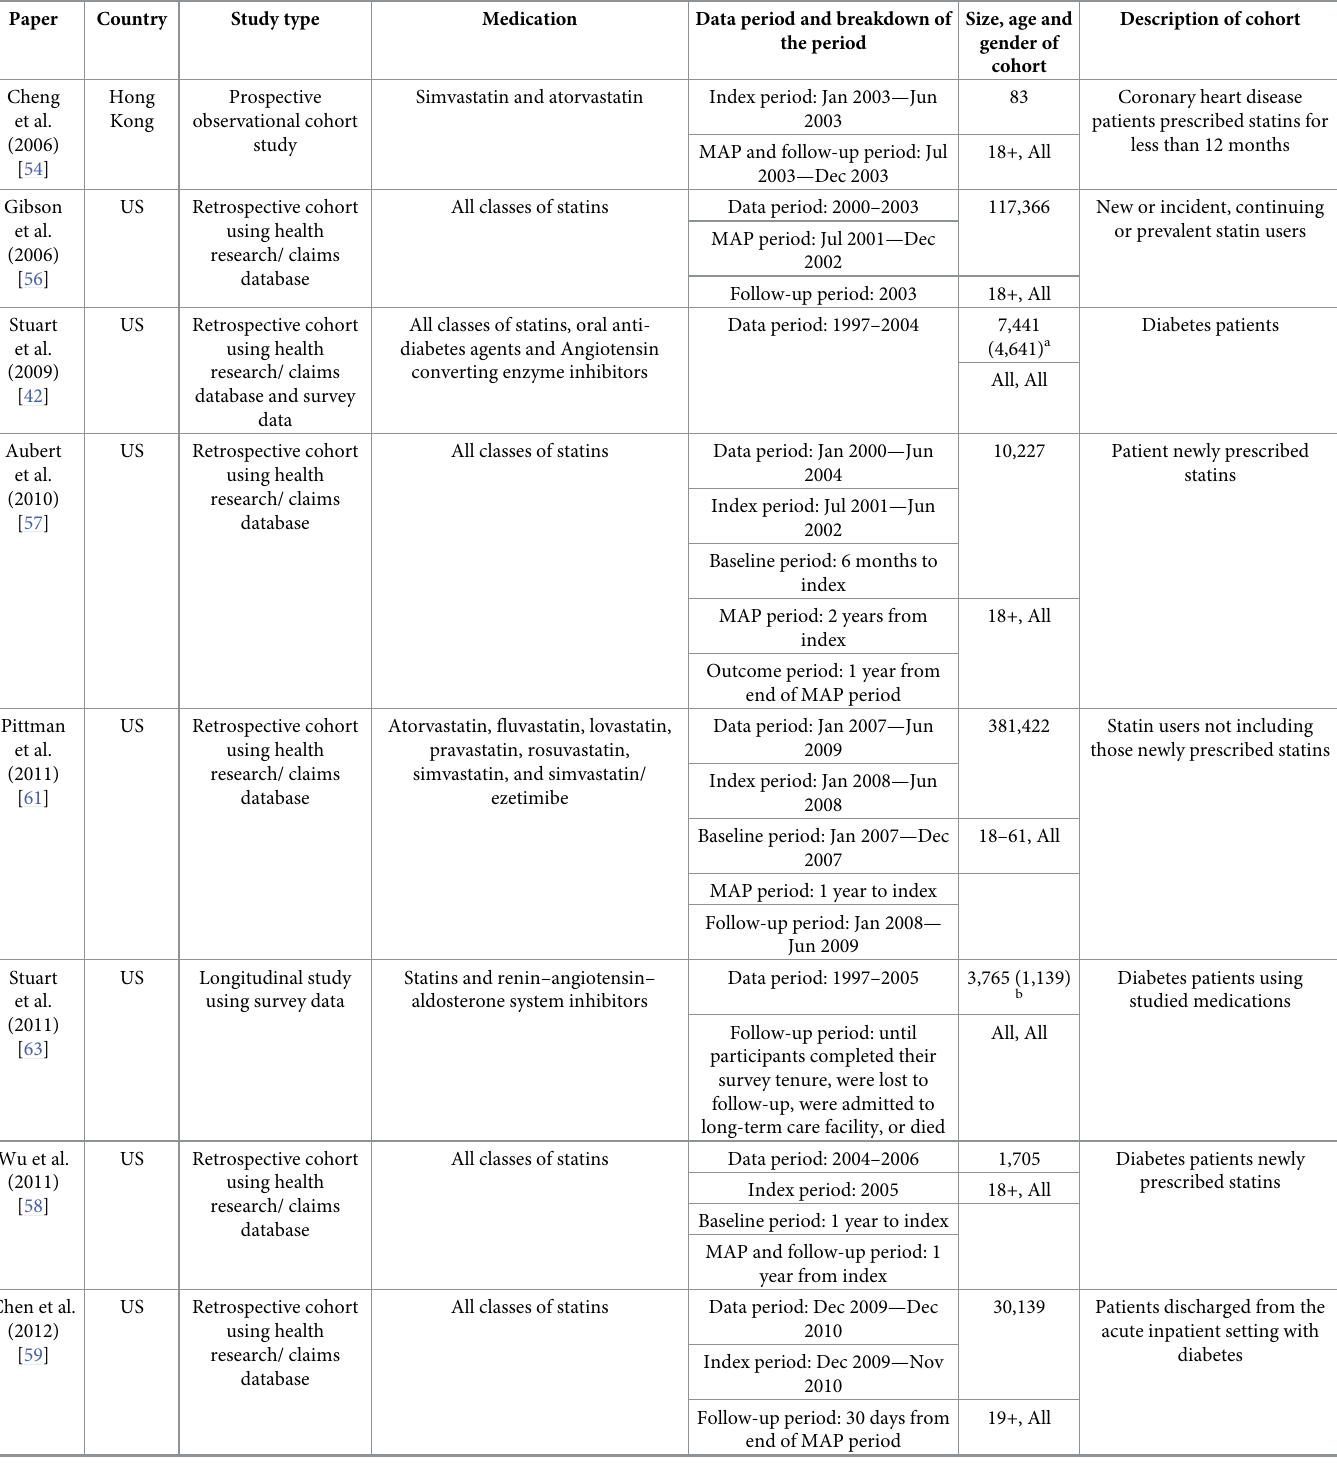
Table 5. Characteristics of reviewed studies on statins.